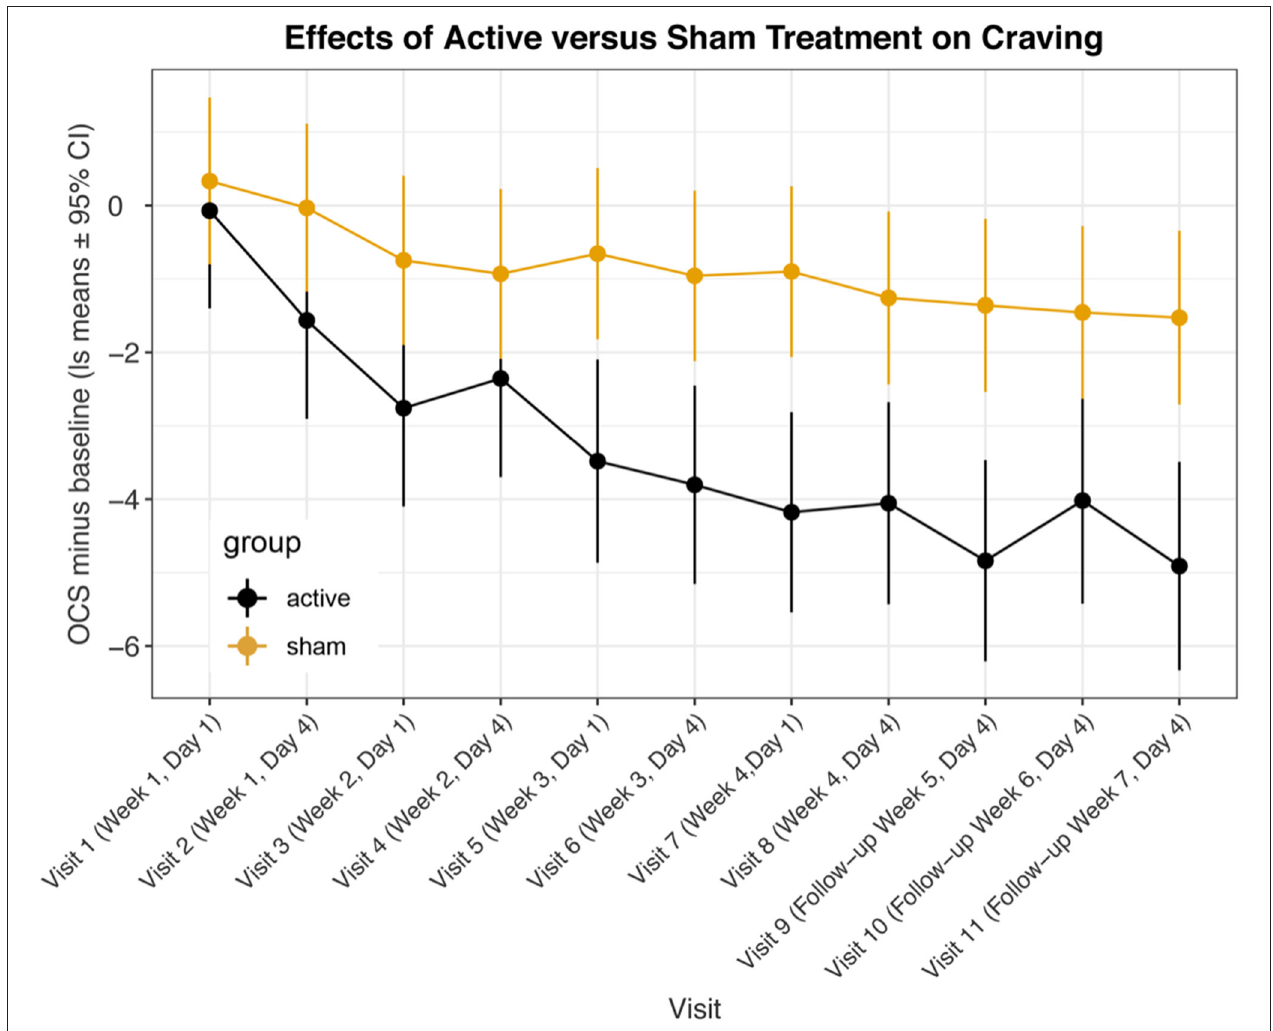
FIGURE 1 | Least square means for opioid craving scores minus baseline from mixed model comparing active vs. sham treatments across visits. Data are means ± 95% confidence intervals.